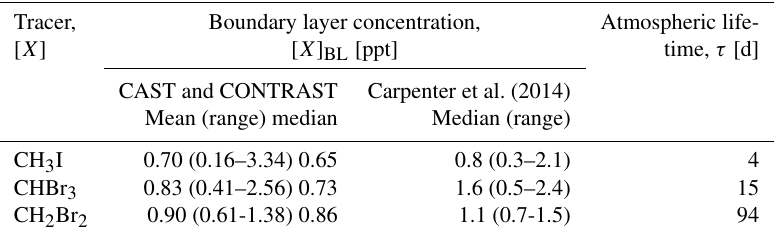
Table 1. Boundary layer concentrations and atmospheric lifetimes for CH 3 I, CHBr 3 and CH 2 Br 2 (Carpenter et.al., 2014).